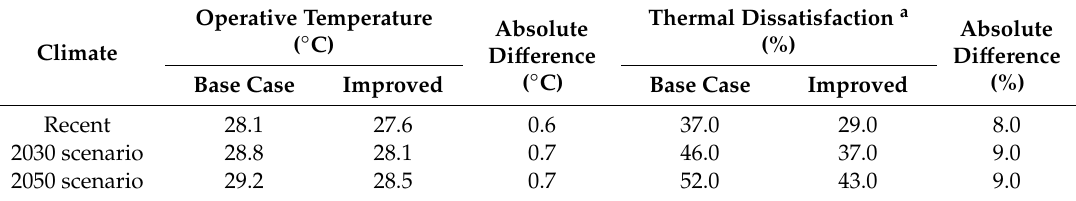
Table 10. Indoor comfort and environmental performances of the building as-built and with improvement strategies.